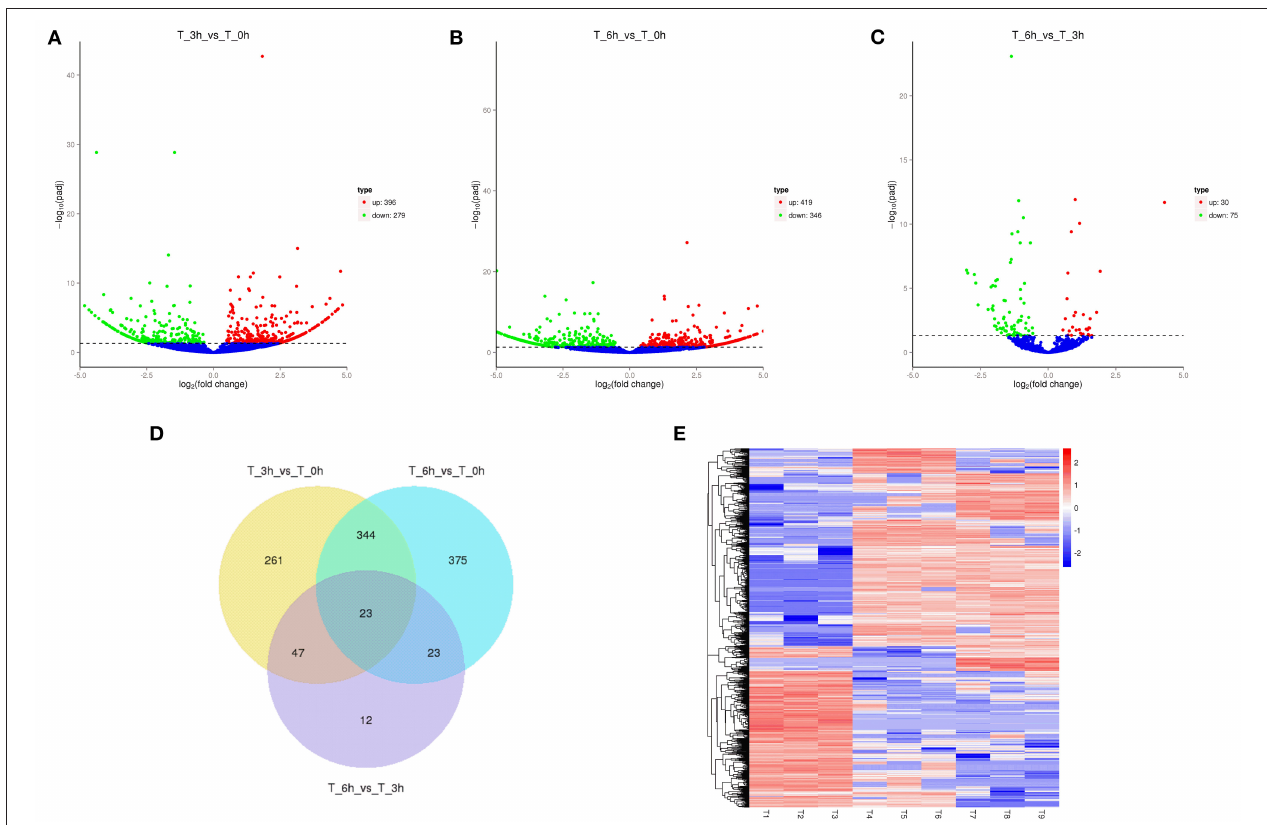
FIGURE 2 | Changes in mRNA expression during SE infection in duck granulosa cells. (A–C) Volcano plots showing up- and down-regulated mRNAs of 3 vs. 0, 6 vs. 0, and 6 vs. 3 hpi group, respectively. (D) Venn diagram showing the number of overlapping differentially expressed mRNA between 0, 3, and 6 hpi. (E) Heat map of mRNAs showing hierarchical clustering of DE-mRNAs between 0, 3, and 6 hpi. Up- and down-regulated mRNAs are shown in red and blue, respectively.